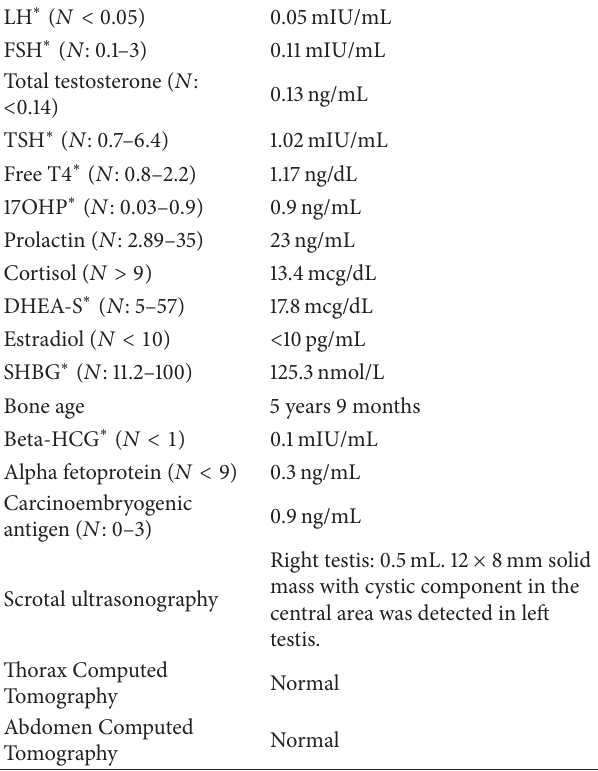
Table 1: Results of laboratory and imaging studies of the